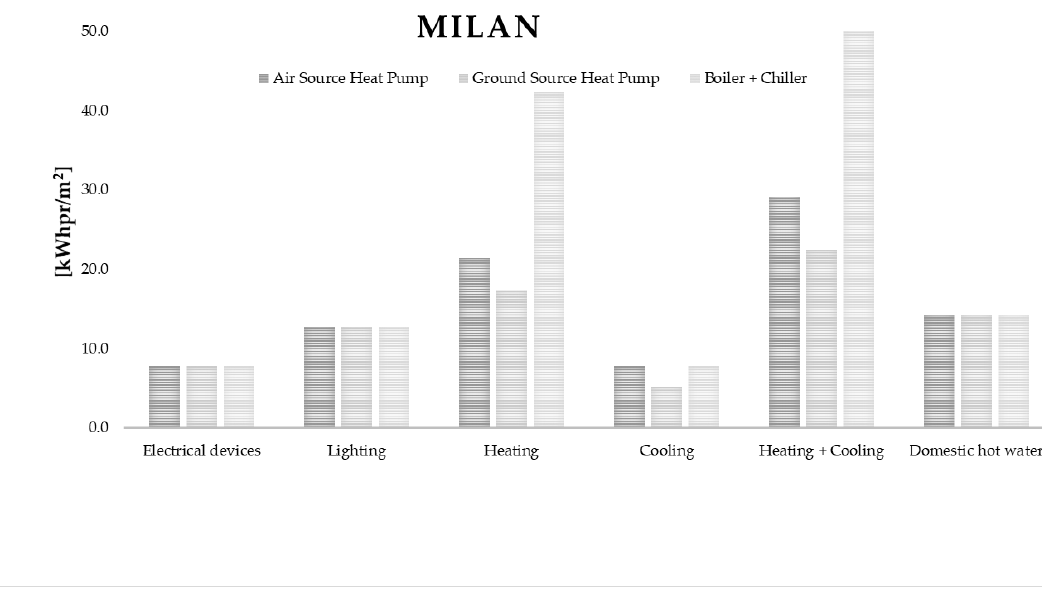
Figure 6. Entire yearly demand of primary energy (kWh/m 2 y) for the three analysed solutions in the case of Palermo.